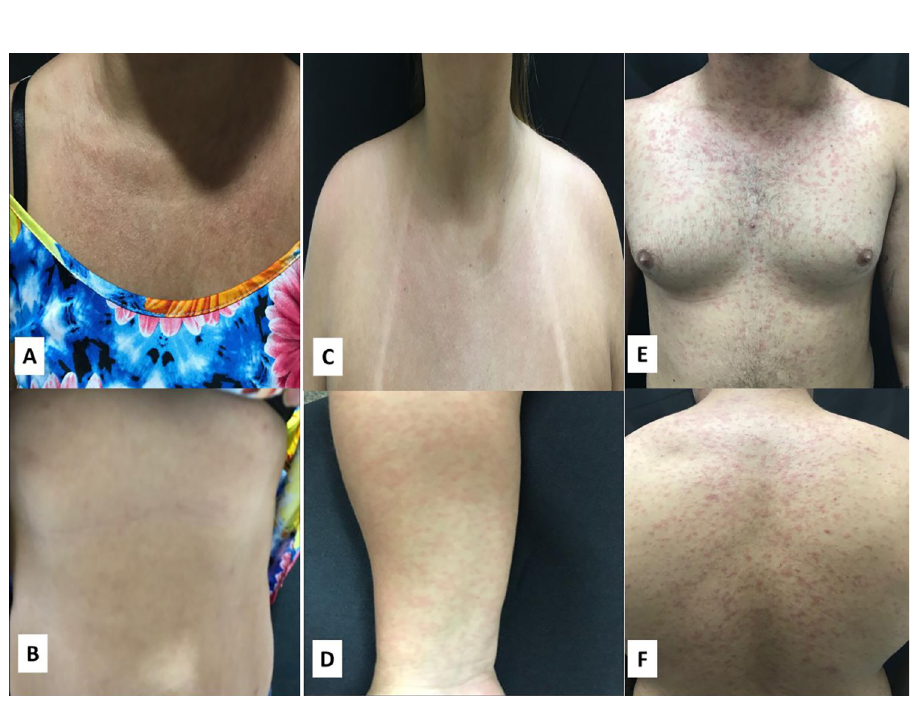
Fig 3. Rashes observed in patients diagnosed with other infectious diseases in this study. (A and B) rash observed on thorax and abdomen of an HIV-positive patient. (C and D) rash observed on thorax and upper limbs of a syphilis- positive patient. (E and F) rash observed on anterior and posterior thorax of a measles-positive patient.